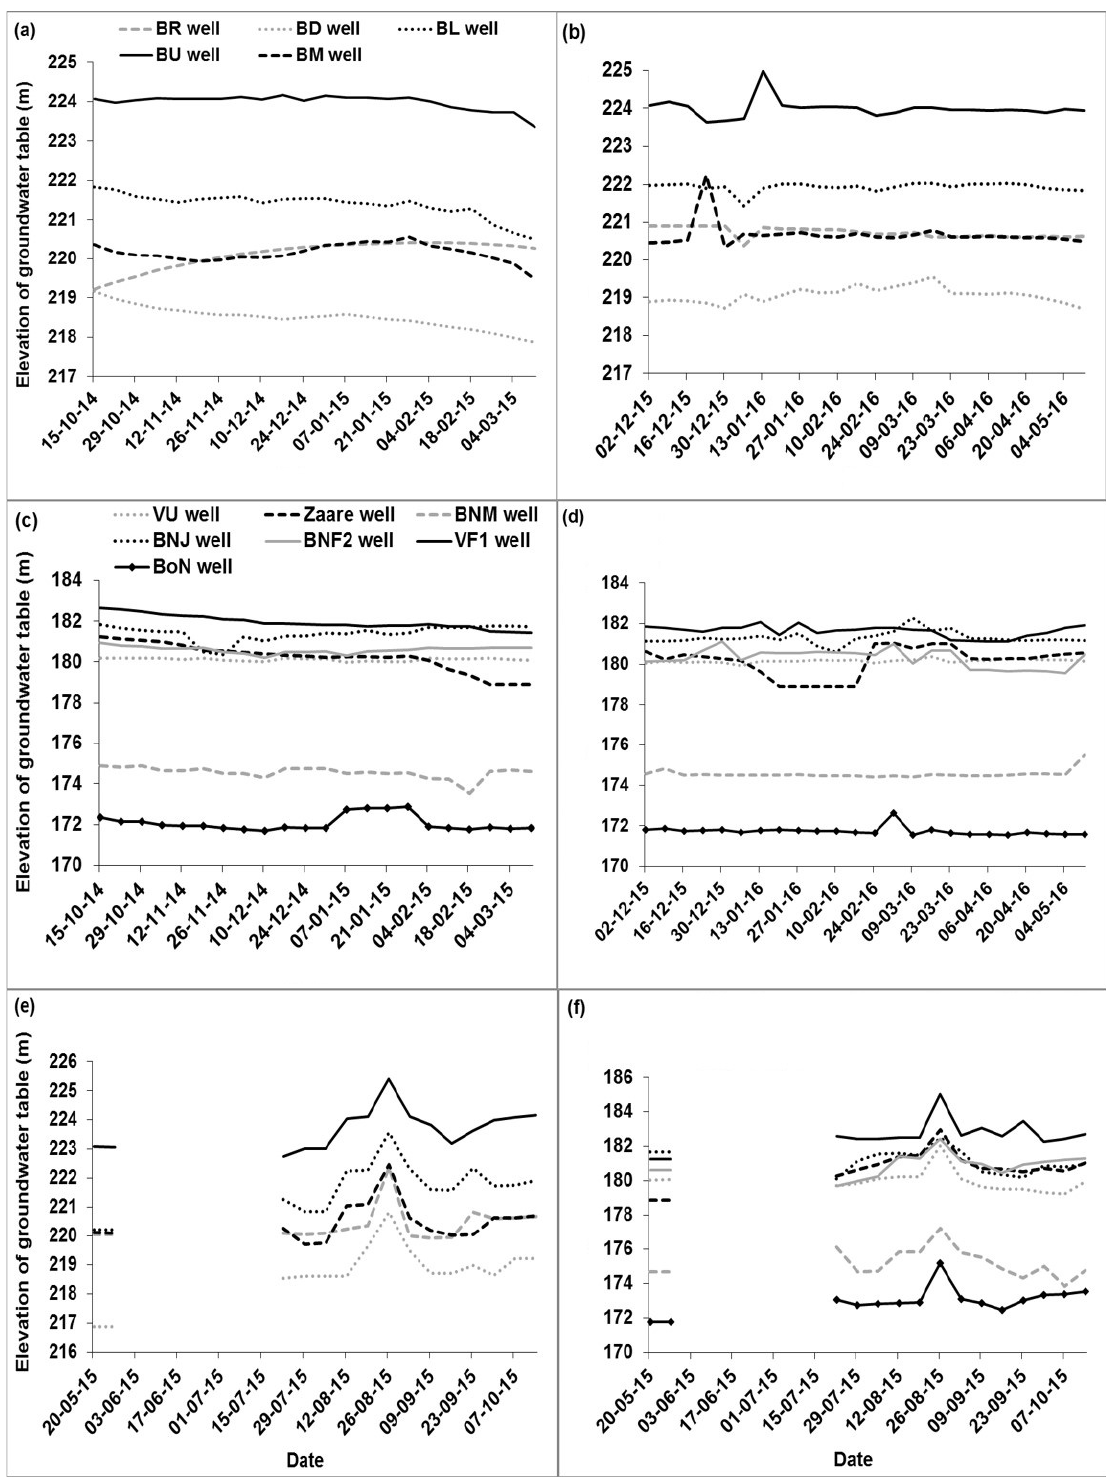
Figure 8. Elevation of the groundwater table during ( a ) 2014–2015 dry season in Bongo ( b ) 2015–2016 dry season in Bongo ( c ) 2014–2015 dry season in Vea ( d ) 2015–2016 dry season in Vea ( e ) 2015 rainy season in Bongo and ( f ) 2015 rainy season in Vea.